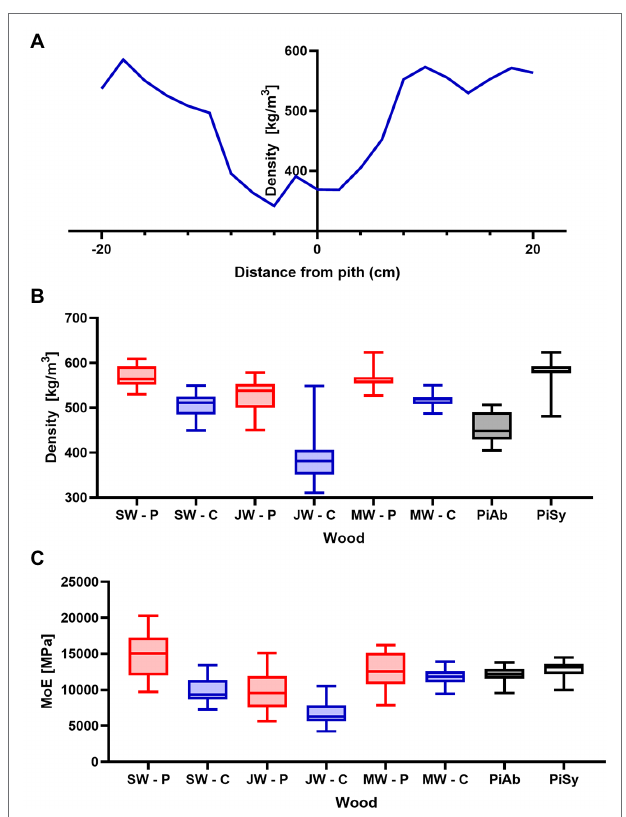
FIGURE 3 | Relevant properties of the analysed wood species from various locations. (A) Density profile of Douglas fir from Planina. (B) Densities of Douglas fir from Planina (P) and Celje (C) and (C) Modulus of elasticities of Douglas fir from Planina (P) and Celje (C).